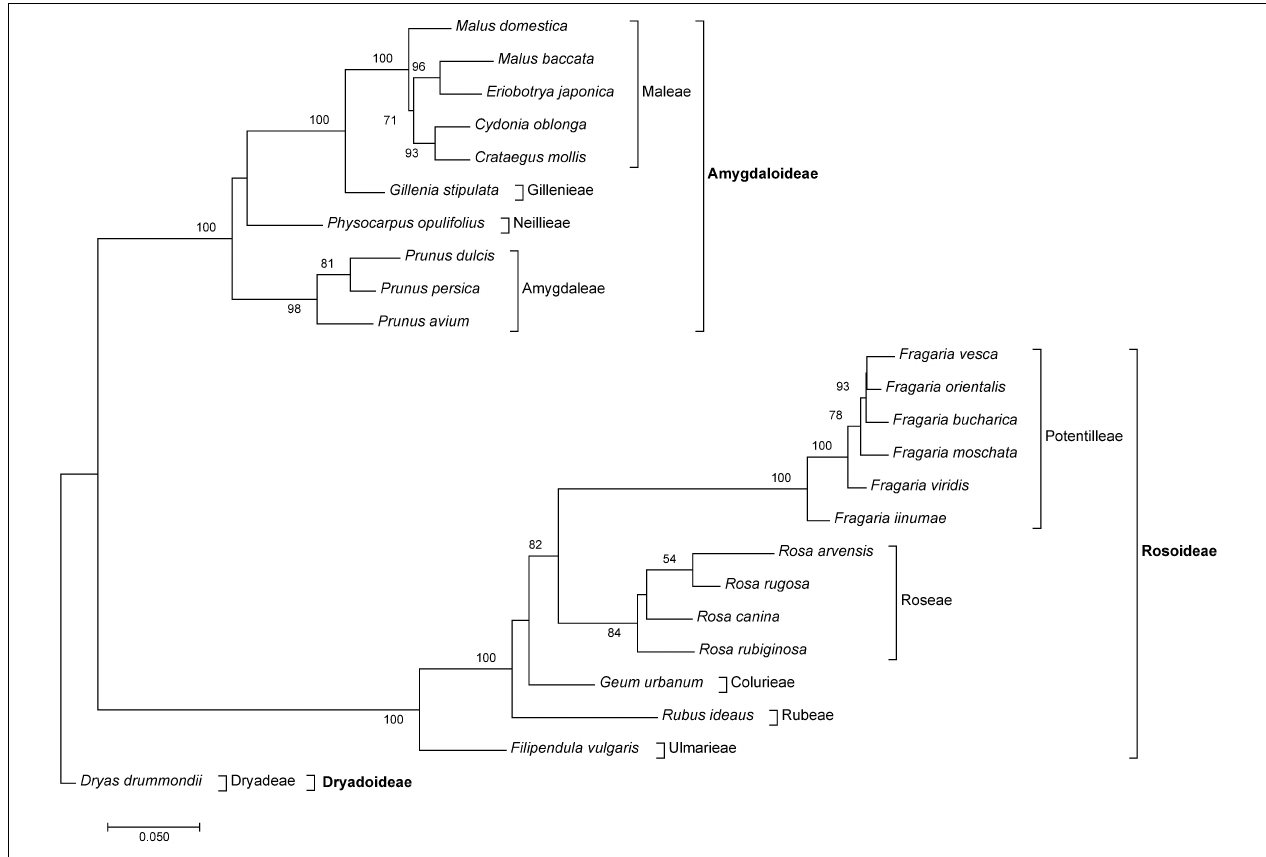
FIGURE 4 | The neighbor-joining tree of Rosaceae species based on Gower distance calculated from the sum of 85 obs-distances (inverted observed/expected numbers of edges matrices remaining after removal of matrices containing NAs) obtained from the comparative RepeatExplorer2 output. Bootstrap percentages > 50% are given above branches. The tree was rooted with Dryas drummondii . Subfamilies and tribes are indicated after